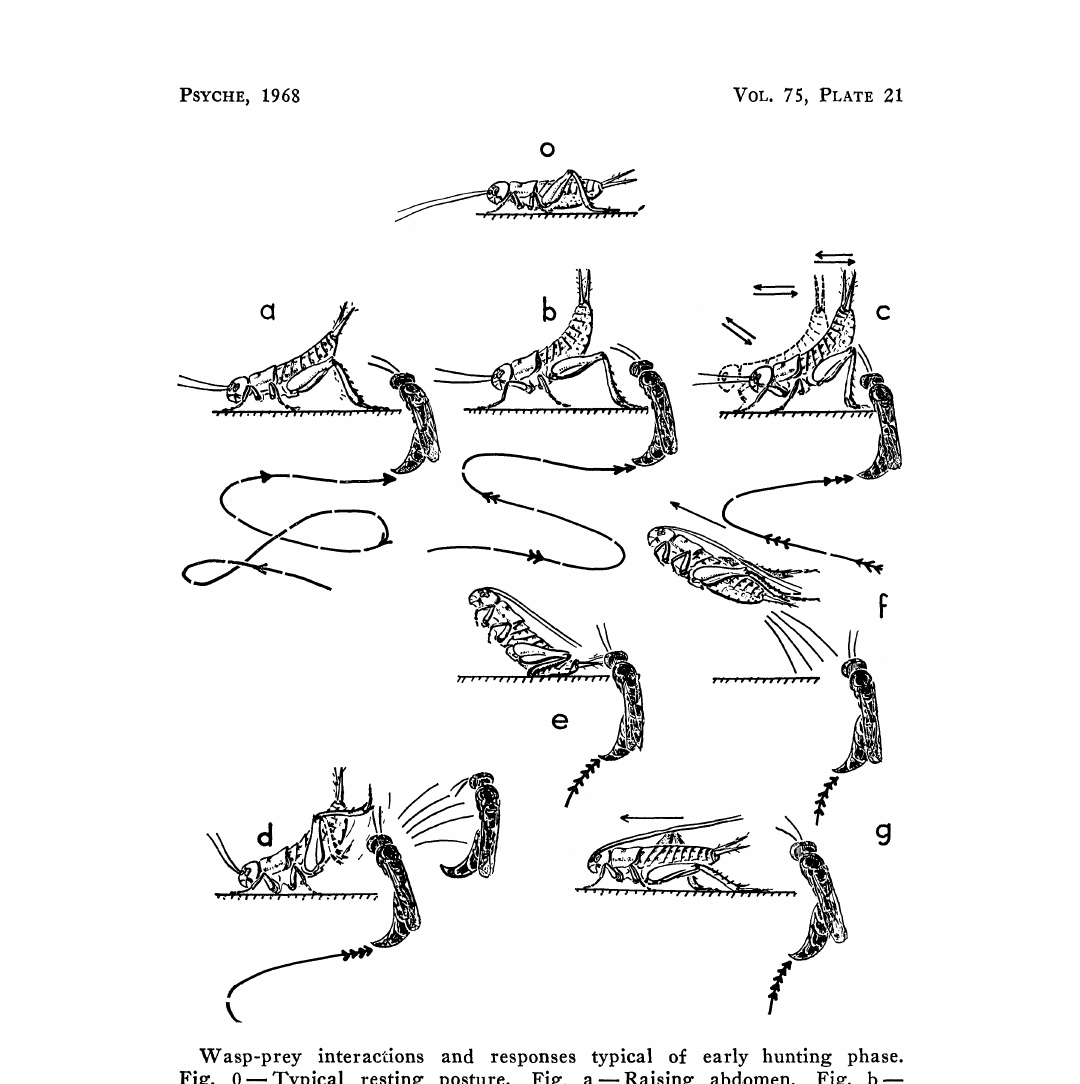
Wasp-prey interactions and responses typical of early hunting phase. Fig. 0--Typical resting posture. Fig. a--Raising abdomen. Fig. b-- Tilted posture. Fig. c--Body swaying, in tilted posture. Fig. d---Kicking with jumping (hind) legs. Figs. e, f--Jumping away. Fig. g--Running away. Solid lines indicate movements and displacements of prey. Inter- rupted lines indicate the path followed by the wasp. Increasing vigor of attacks is represented by increasing number of arrows from a to f. Explana- tions in